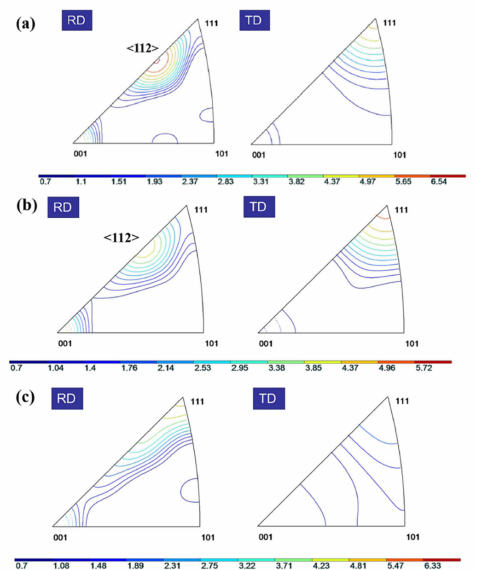
Figure 10. IPF results of hot rolled plates after different solution treatments: ( a ) 25 mm plates treated for 90 min; ( b ) 65 mm plates treated for 30 min; ( c ) 120 mm plates treated for 90